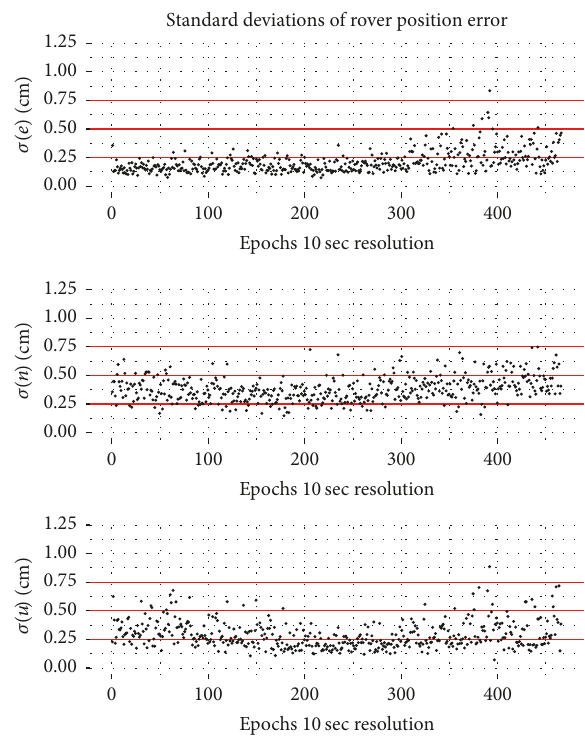
Figure 17: Standard deviations of the rover position errors (𝜎 ,𝜎 ,𝜎 ) inthetopocentriccoordinatesystem.Horizontallinesare 𝑒 𝑛 𝑢 used for classification. Baseline of ∼ 1km, year: 2013, DOY: